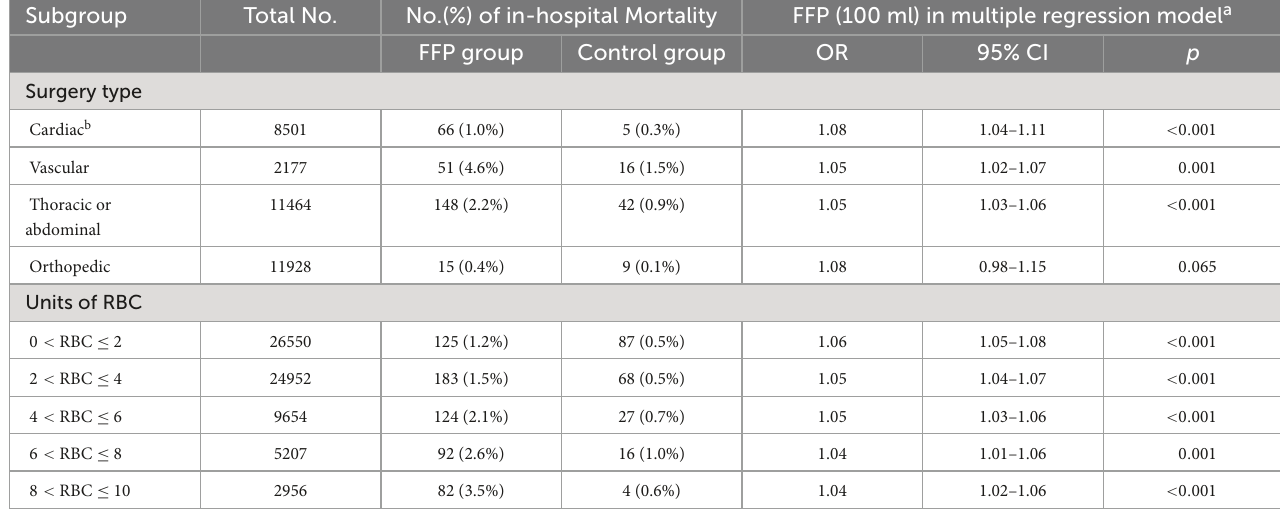
TABLE 4 Multivariable logistic regression analysis of in-hospital mortality in subgroups.